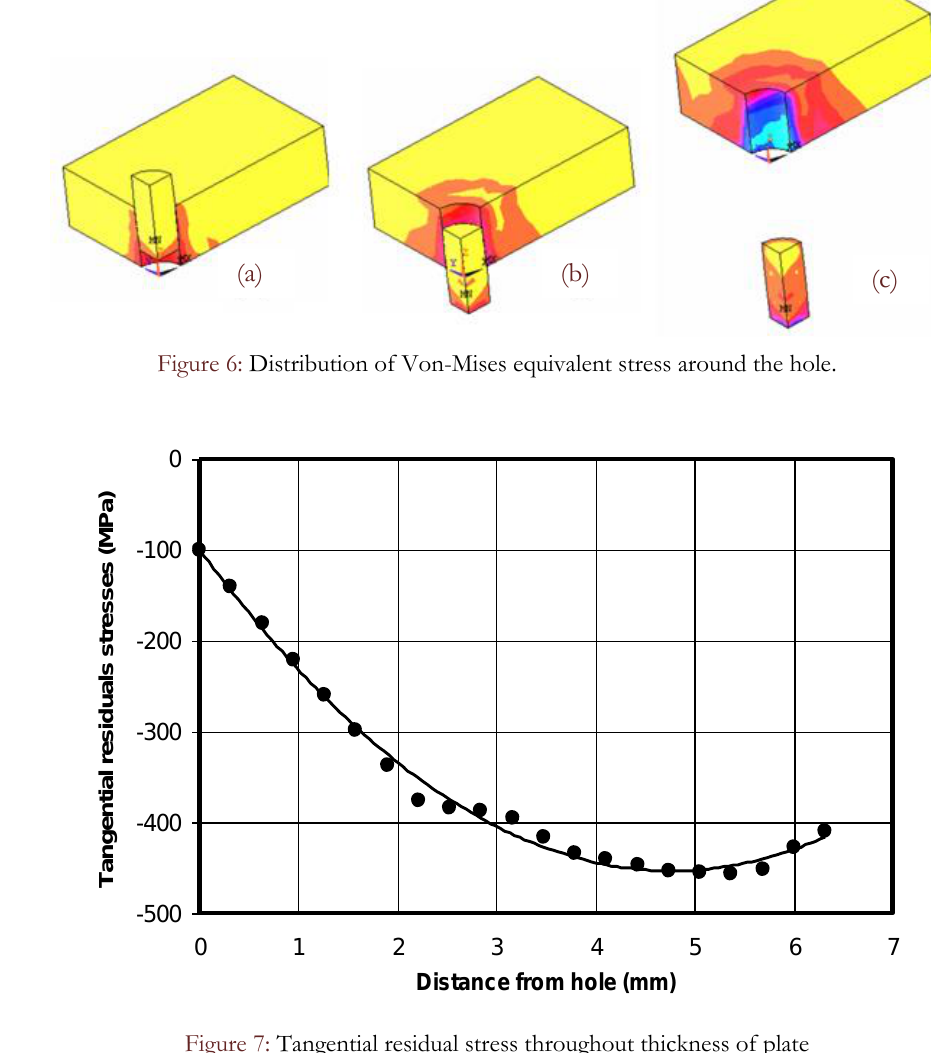
Figure 7: Tangential residual stress throughout thickness of